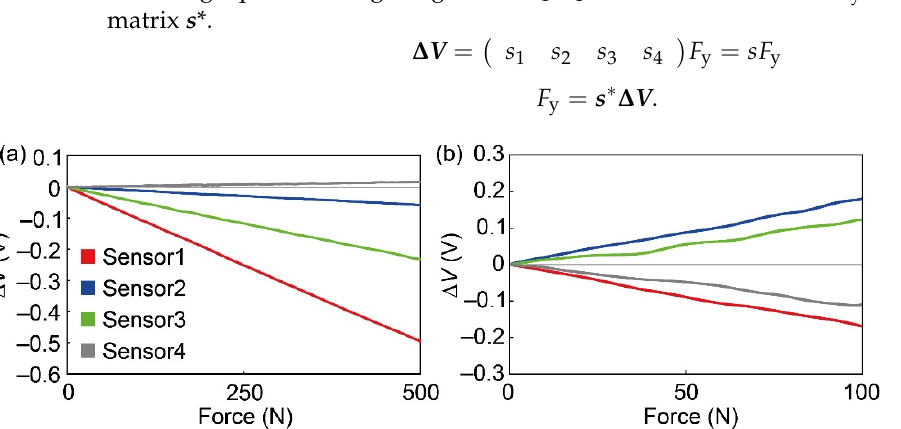
0.054 N/m, and M y : 0.15 N/m.